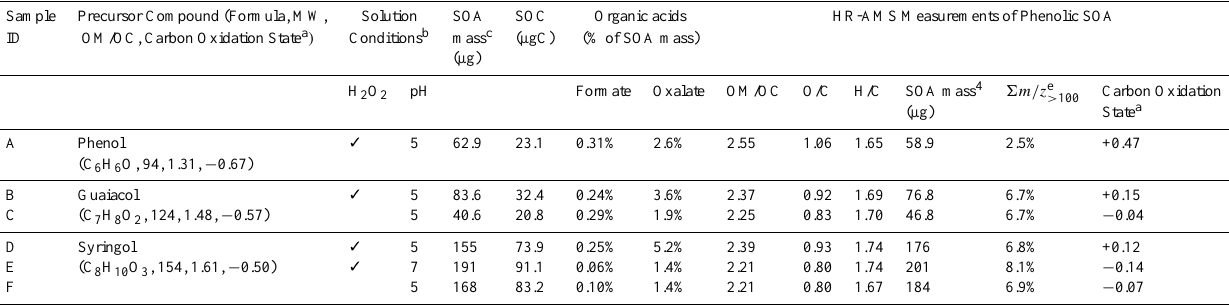
Table 1. Summary of the SOA products of phenolic precursors obtained from aqueous photochemical reactions under different experimental conditions. Sample Precursor Compound (Formula, MW, Solution SOA Organic